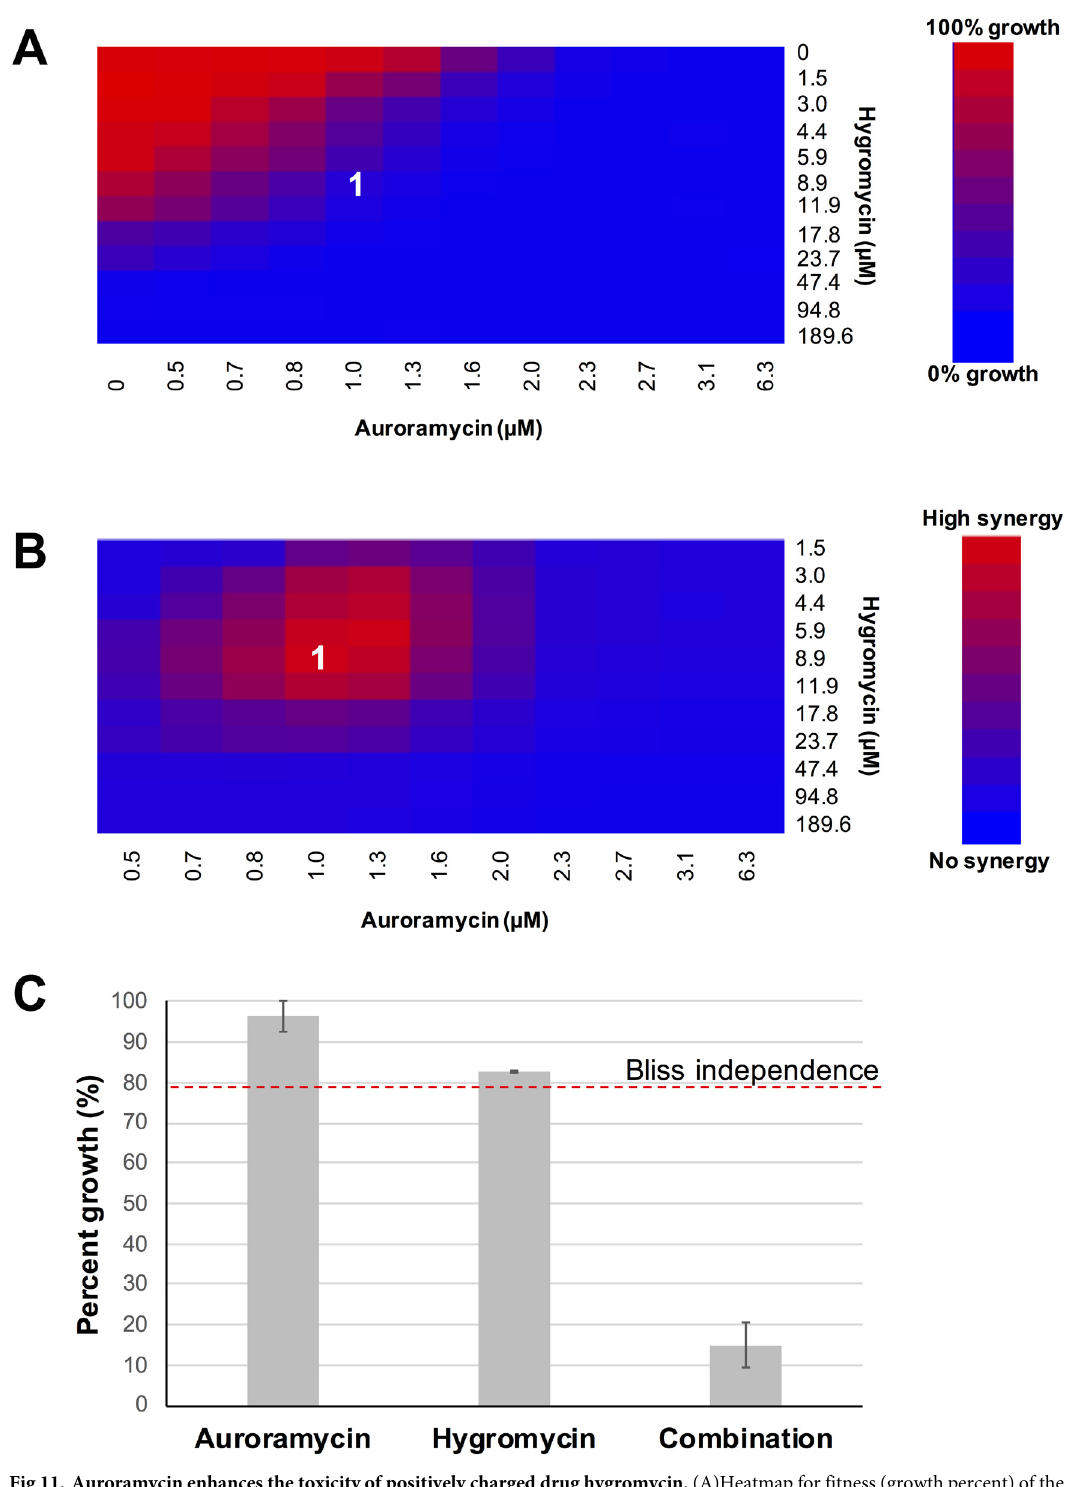
Fig 11. Auroramycin enhances the toxicity of positively charged drug hygromycin. (A)Heatmap for fitness (growth percent) of the dose interaction matrix. (B)Corresponding heatmap for the synergy calculations, based on bliss independence model. Synergy is calculated based on bliss calculations less growth percent. (C)Representative growth rates at 8.9 μ M hygromycin and 1.0 μ M auroramycin (labelled as (1) in A, B), in comparison to the bliss independence model calculation, P < 0.003. Experiments were performed in triplicates. Error bars (n = 3 Mean ± S.D) are indicated in the plot.